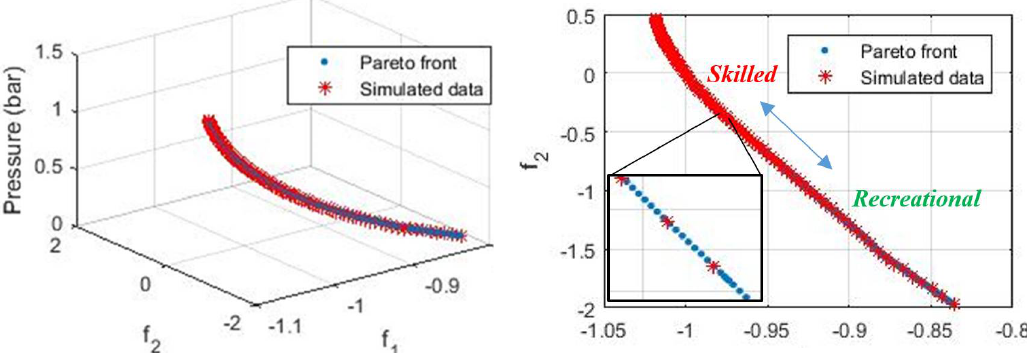
Figure 5. The Pareto front of